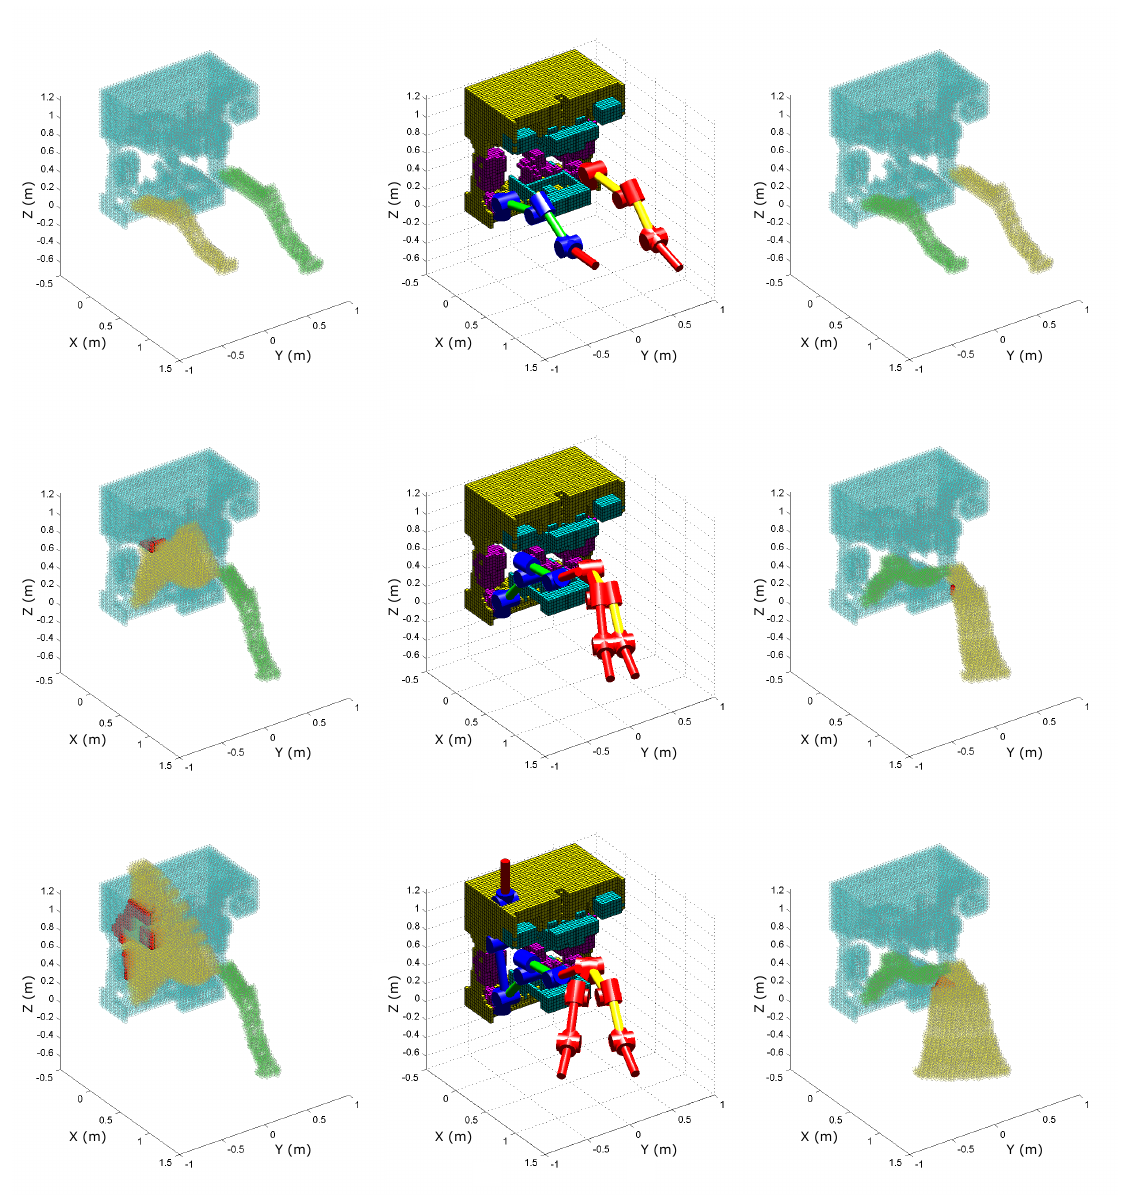
Figure 9. Simulation of the collision detection between each manipulator and the